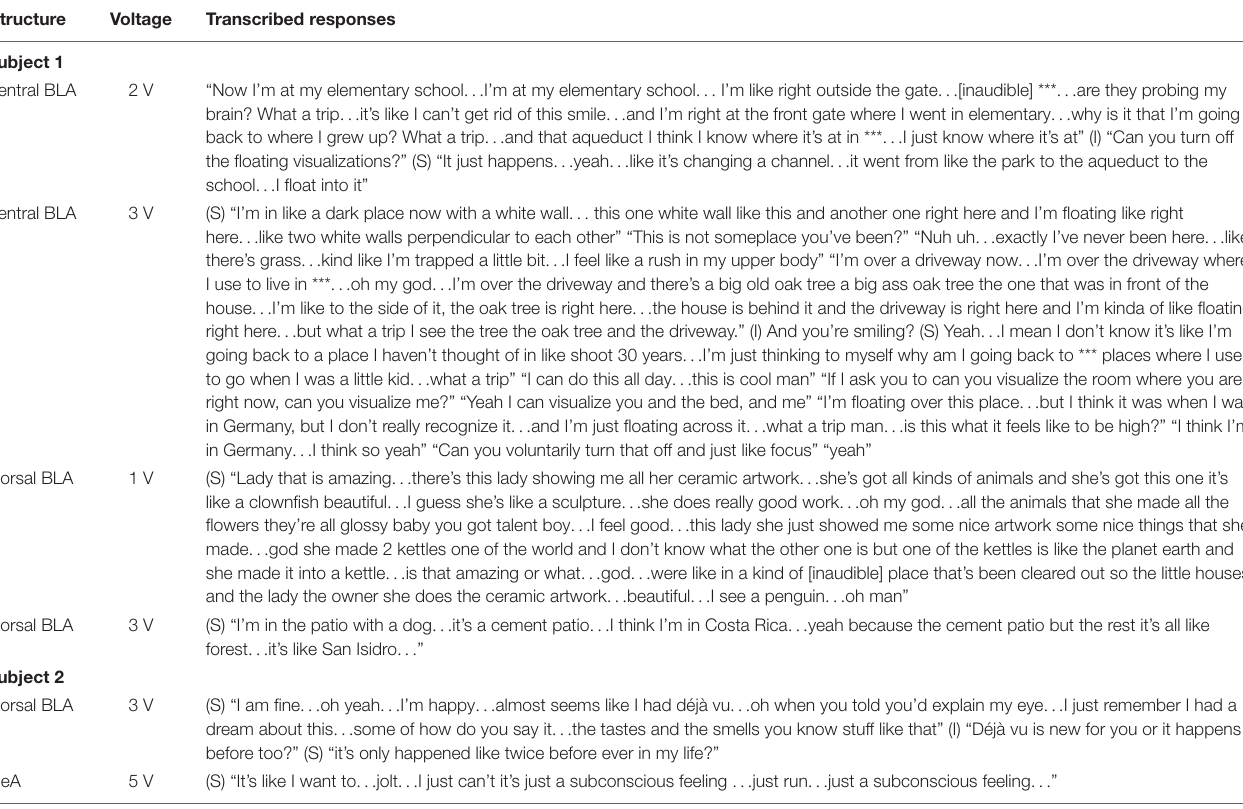
TABLE 2 | Transcriptions of example responses from both subjects pertaining to the dreamy state and double consciousness.